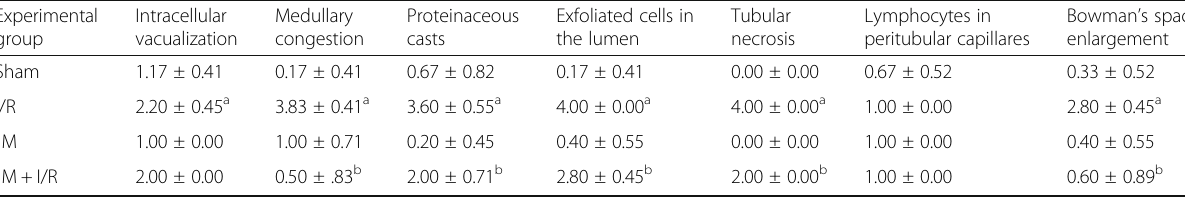
Values represent the mean±S.D. (n=6) of histopathological grade. Grade: no change (0), mild (1), moderate (2), severe (3), very severe (4). a. p <0.05, comparison with the sham group; b. p <0.05, comparison with IR